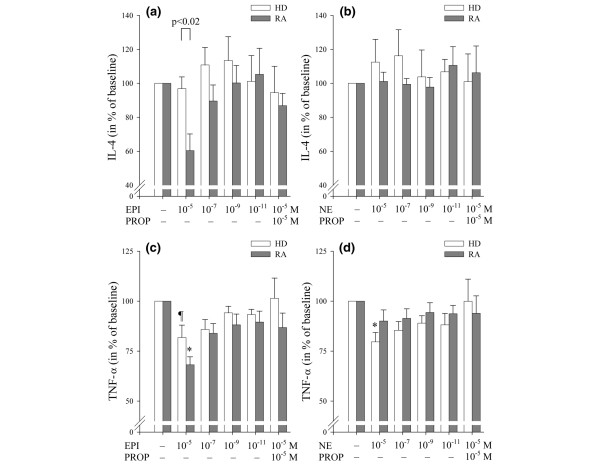
Modulation of interleukin (IL)-4 and tumour necrosis factor (TNF)-α synthesis of activated T cells by catecholamines in healthy donors (HDs) (IL-4: n = 6; TNF-α: n = 5, white bars) and patients with rheumatoid arthritis (RA) (IL-4: n = 5; TNF-α: n = 7, gray bars). The concentrations of IL-4 upon co-incubation with (a) epinephrine (EPI) and (b) norepinephrine (NE) and of TNF-α upon co-incubation with (c) EPI and (d) NE were determined in the culture supernatant by means of enzyme-linked immunosorbent assay after T-cell stimulation for 48 hours. The baseline values of each HD and patient with RA were defined as 100%, and the cytokine concentrations upon co-incubation with catecholamines are given as percentage of baseline values. *p < 0.001 and ¶p < 0.05 as compared with values obtained upon stimulation in the presence of medium alone. P values indicate significant differences between the catecholamine effects of patients with RA and HDs, respectively. PROP, propranolol.